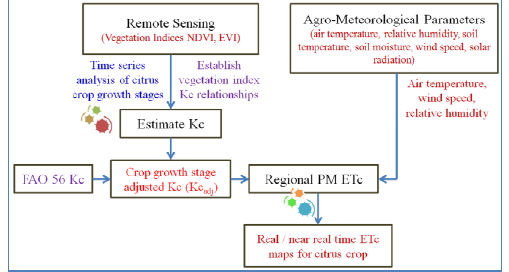
Figure 3. Data processing flowchart for RS based citrus crop ET estimation